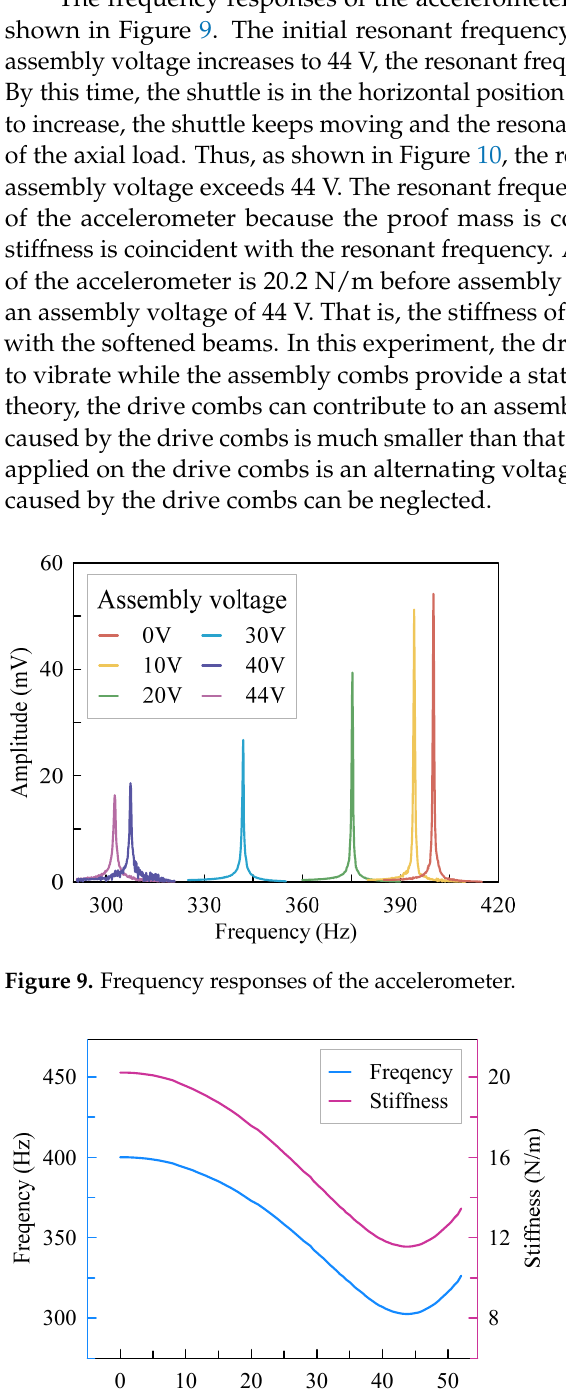
Figure 8. Schematic of the CVC readout circuit.